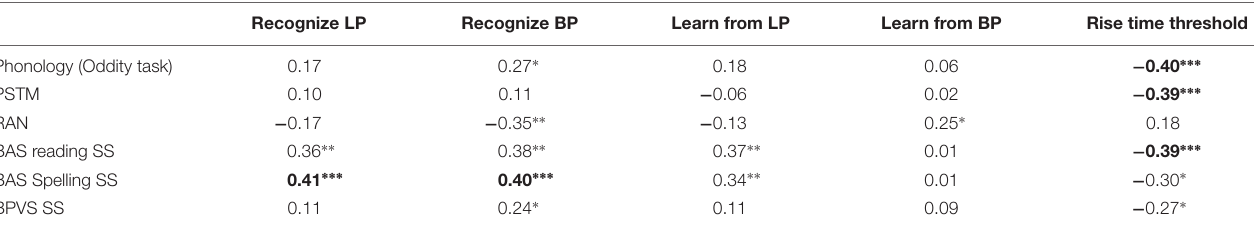
TABLE 4 | Partial correlations between children’s performance in the phonology, vocabulary and reading/spelling outcome measures and their filtered speech performance and rise time discrimination thresholds, controlling for age and IQ. Recognize LP Recognize BP Learn from LP Learn from BP Rise time